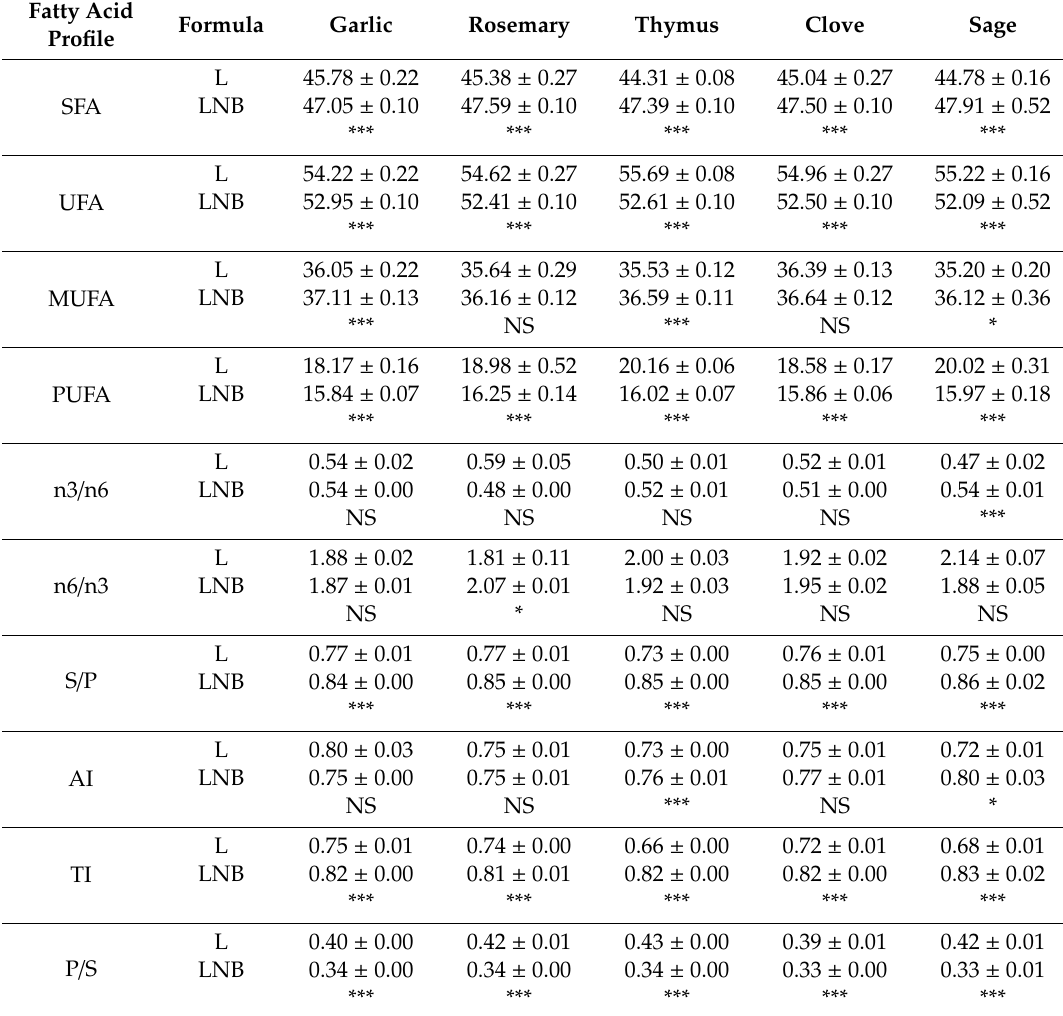
Table 2. Nutritional indexes (%; mean ± s.e.) of spiced lamb meat burgers from two di ff erent formulation types under aerobiosis conditions.